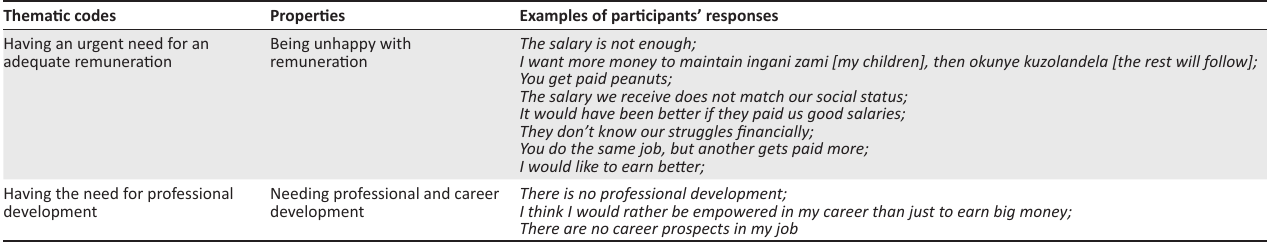
TABLE 7: Thematic codes for focus group responses showing workers’